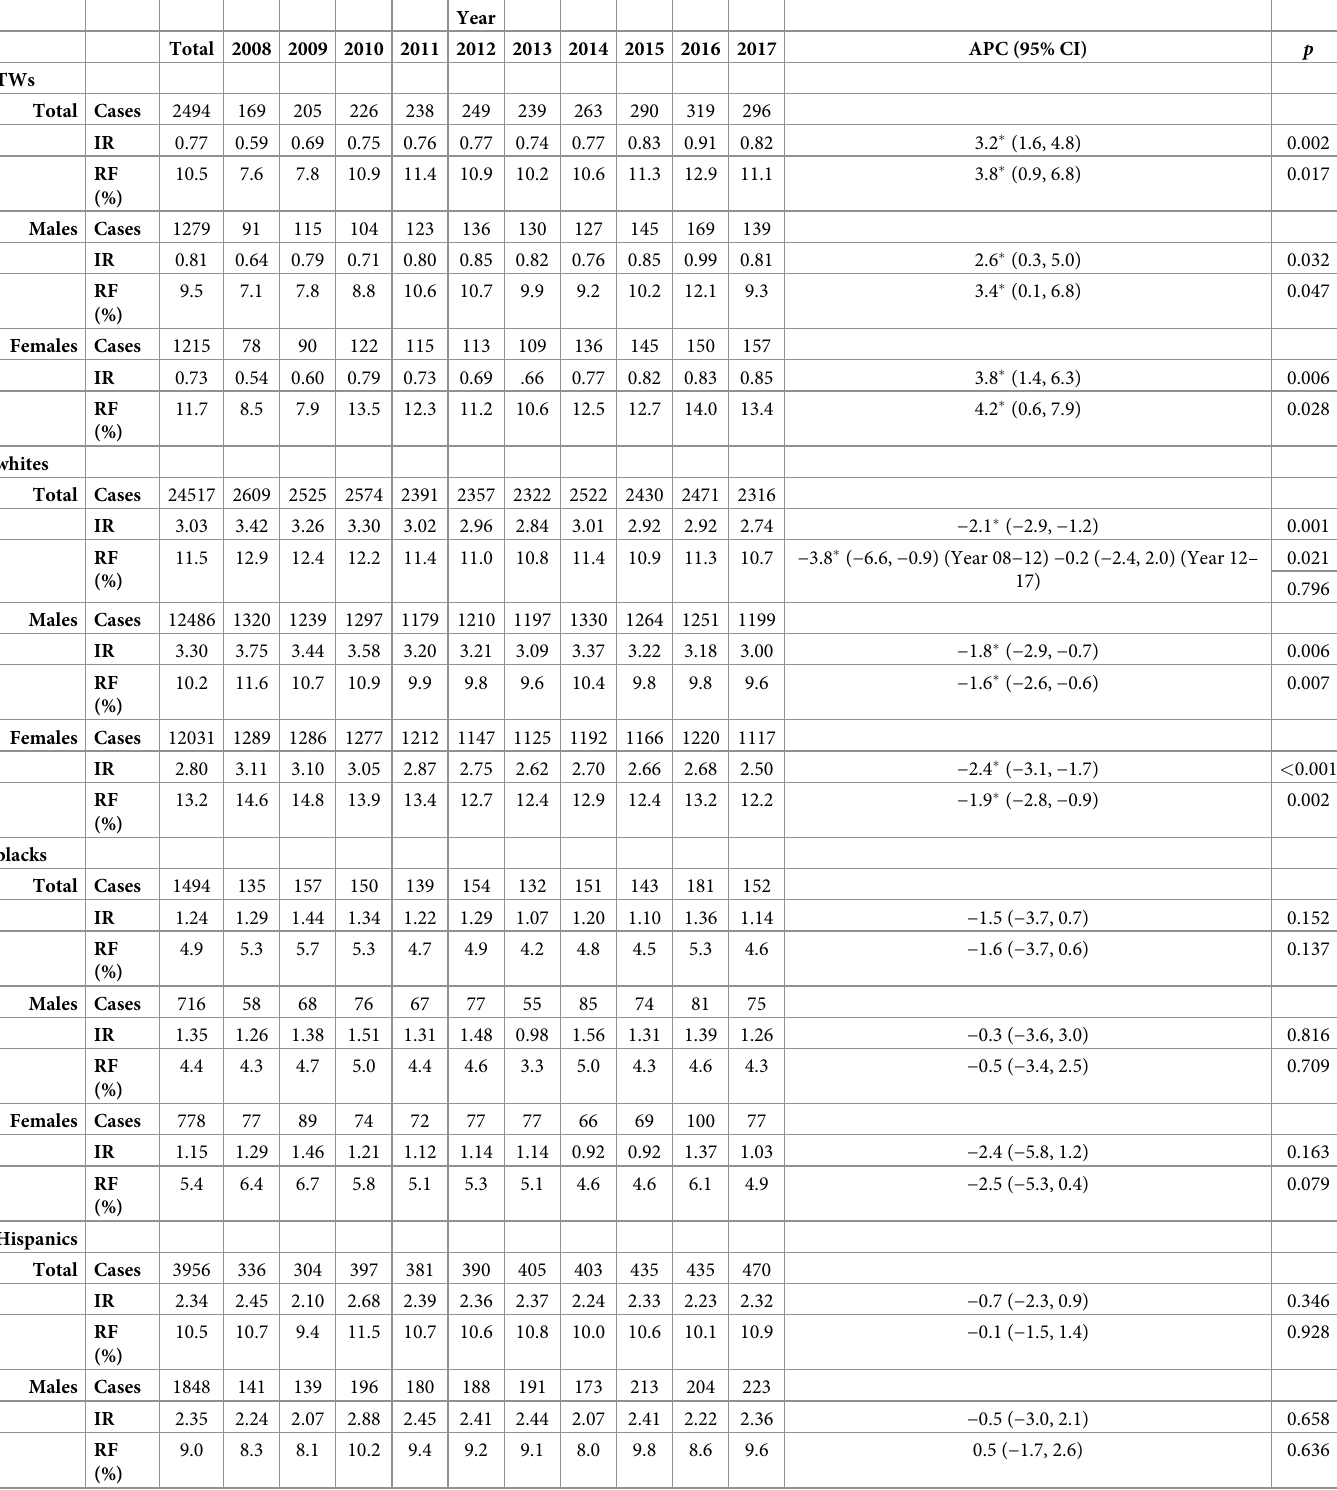
Table 1. Number of follicular lymphoma cases and trends in age-adjusted rates and relative frequency of FL among the incident NHL cases according to sex for the period